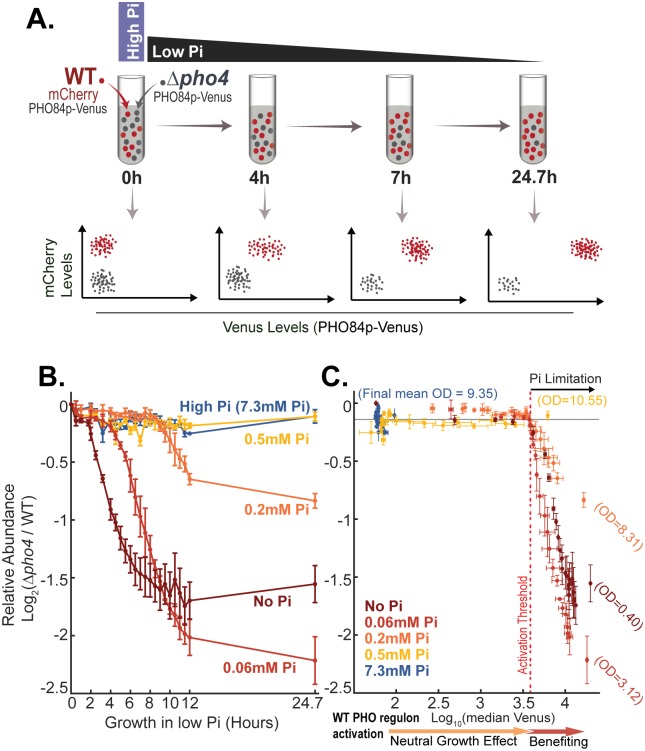
The starvation program promotes growth in low phosphate.(A) Experimental scheme: Cells deleted of PHO4 were mixed with fluorescently labeled wild-type cells and were coincubated in different low-Pi media. Samples were taken at different times following the incubation and analyzed using flow cytometry to define the relative fraction of Δpho4 cells (cells not expressing mCherry) and the activation of the starvation program reporter PHO84p-Venus in individual cells. (B–C) The early phase of Pho4-target gene induction does not contribute to cell growth: The relative abundance of Δpho4 cells in the mixed culture is shown as a function of time (B) and as a function of the PHO84p-Venus reporter induction in wild-type cells (C). The data in (B–C) are the mean and standard error of 2 replicates. The raw data are available in S4 Data. Note that, regardless of the inoculation conditions, Δpho4 cells begin to reduce in frequency when the reporter level increases beyond the same activation threshold at which wild-type cells begin to reduce their growth (compare Fig 1F) and induce the second wave of Pho4-target gene expression (compare S1E Fig). See S2C–S2E Fig for the temporal induction of the reporter and a similar analysis of Δpho81 cells. Pi, inorganic phosphate; WT, wild type.